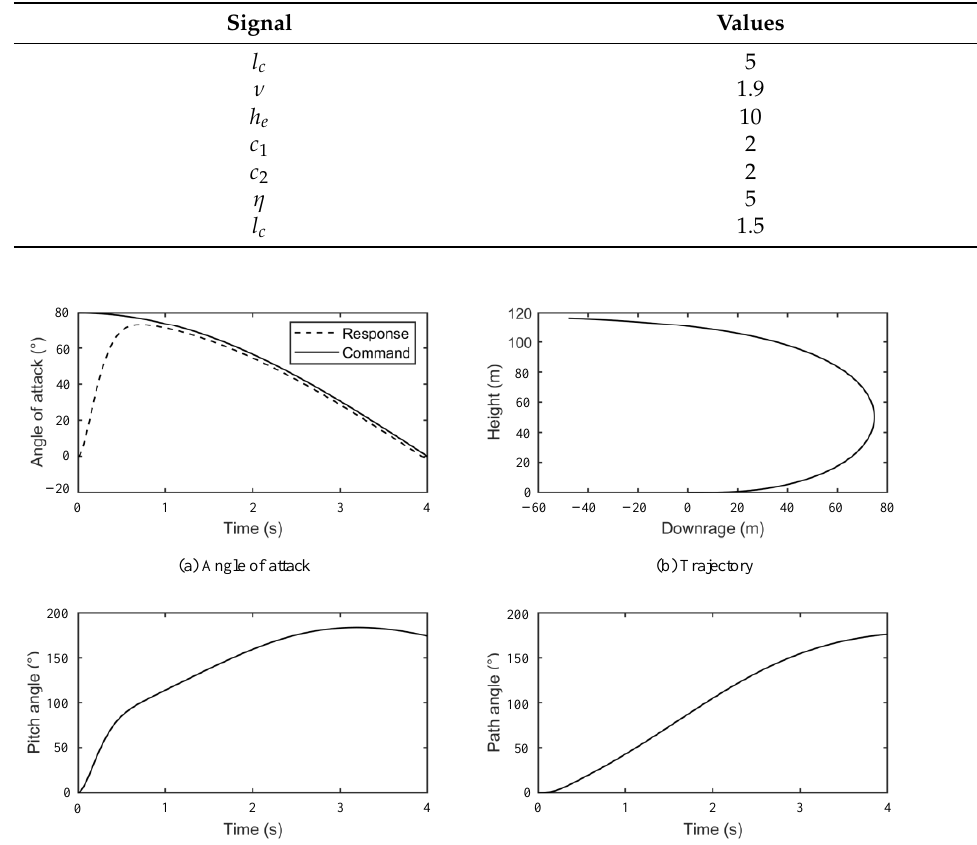
Figure 2. Responses for a command tracking scenario.